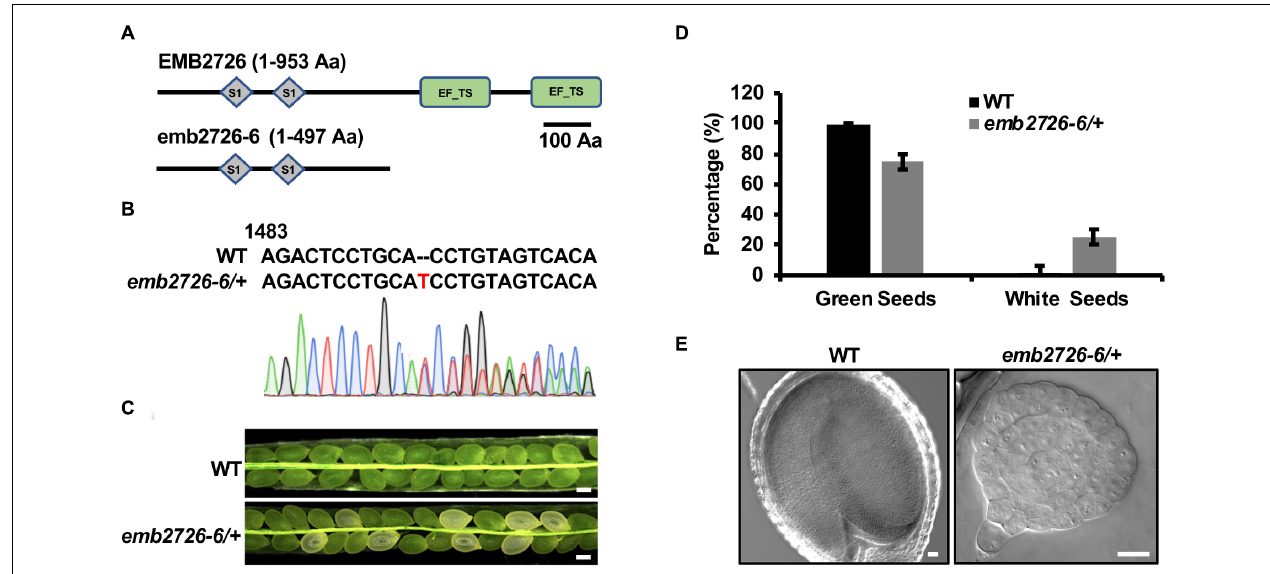
FIGURE 4 | The EF-Ts domains are critical for the function of EMB2726. (A) Schematic diagrams of the full-length EMB2726 protein (top) and EF-Ts domain-deleted version of EMB2726 generated using the CRISPR/Cas9 system (bottom). (B) Sequencing chromatogram of the mutated emb2726-6/ + sequence generated by CRISPR/Cas9. The inserted nucleotide is highlighted in red. (C) Seeds in siliques from WT and emb2726-6/ + plants at 12 DAP. Scale bar = 0.2 mm. (D) Percentages of green and white seeds in WT and emb2726-6/ + siliques as shown in (C) . (E) The embryo phenotypes in green (left) and white (right) seeds at 12 DAP. Scale bar = 20 µ